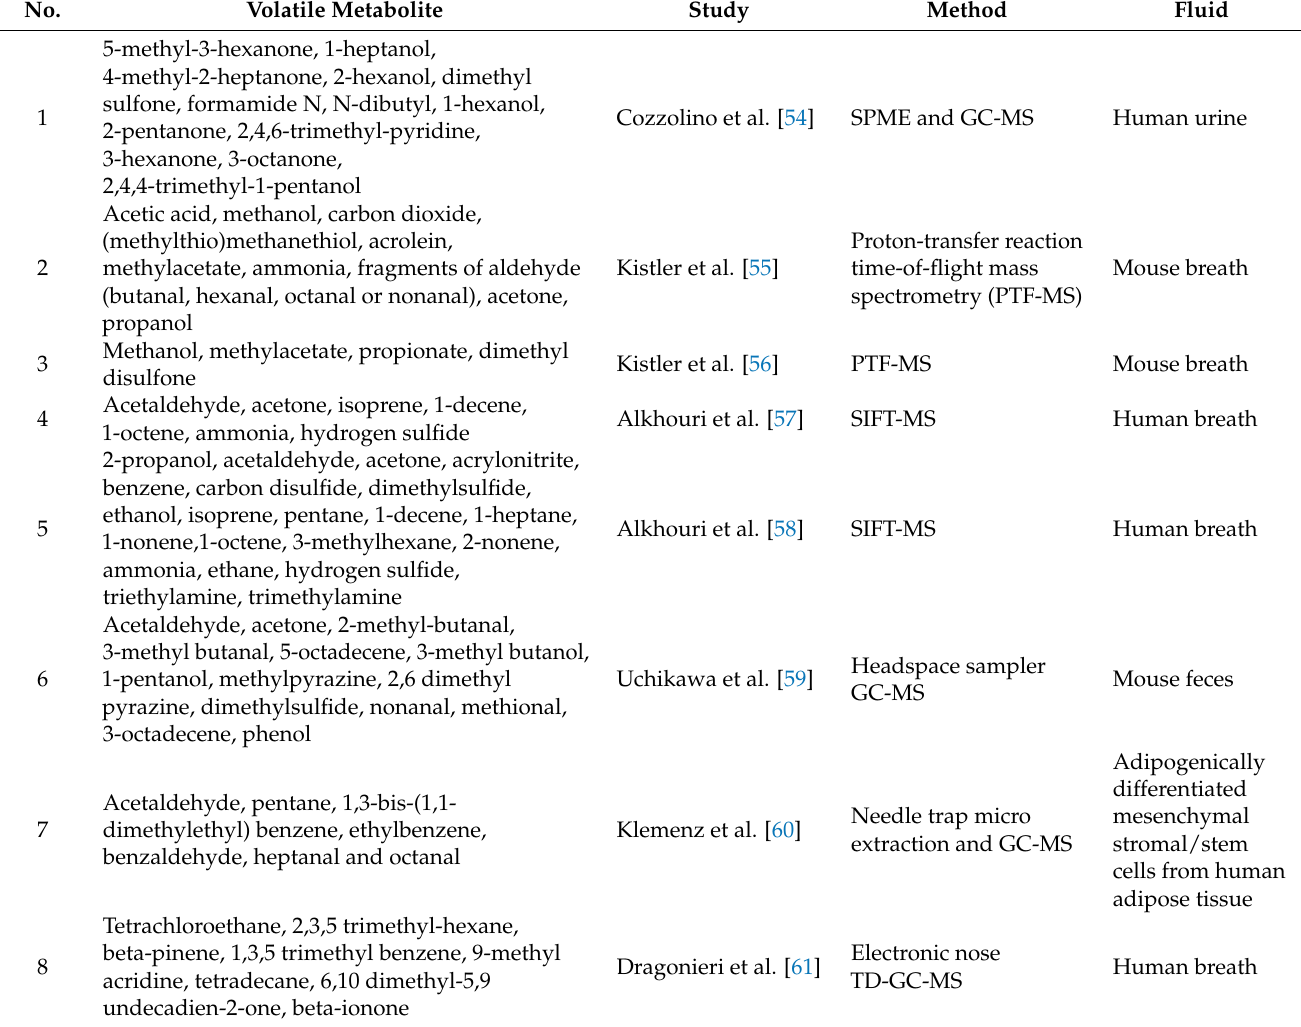
Table 1. Volatile organic compounds evident in obese